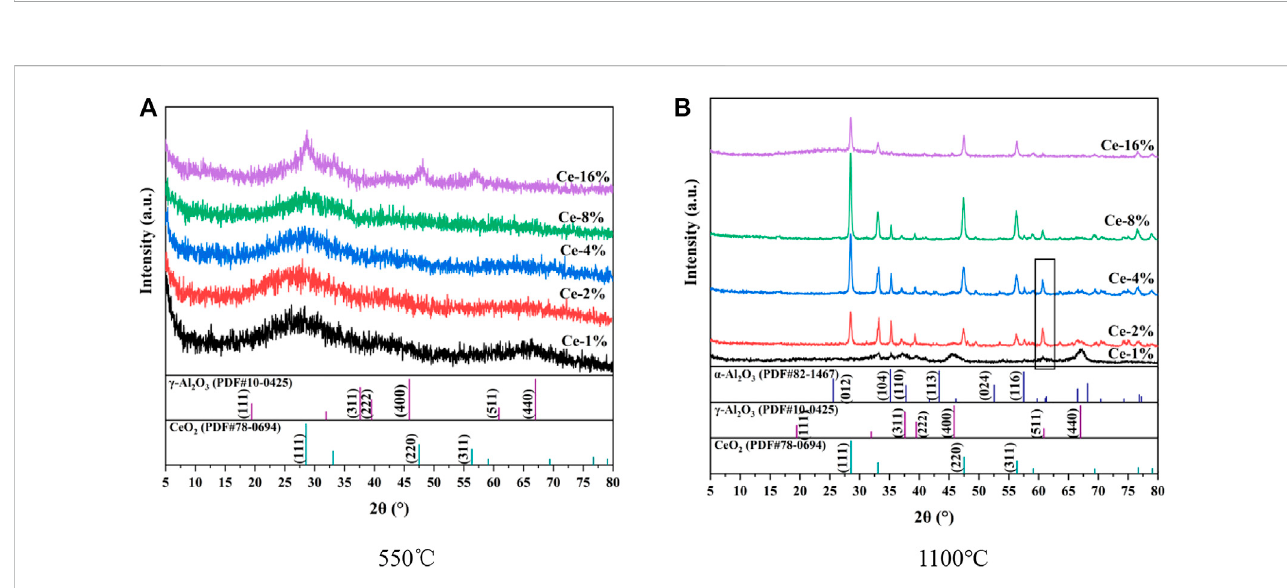
FIGURE 4 XRD pattern of Ce-doped sample calcined at 550 ° C and aged at 1,100 ° C.